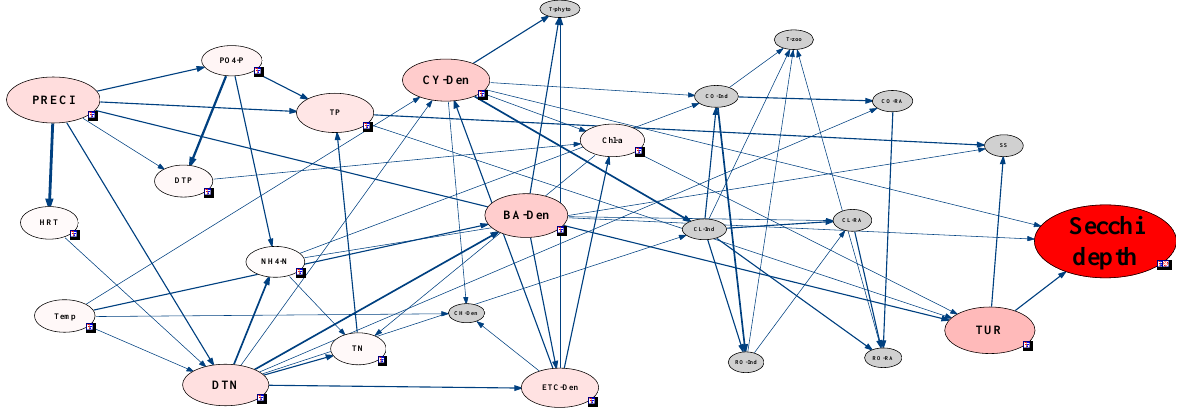
Figure 4. Sensitivity test and strength of influence analysis based on the Bayesian network approach for assessing the clear-water phase (CWP) in the Lake Paldang watershed. The Bayesian network data were discretized using a hierarchical method and bin count 3. The data were collected from four sites in the Lake Paldang watershed, Namhan River, and Bukhan River.